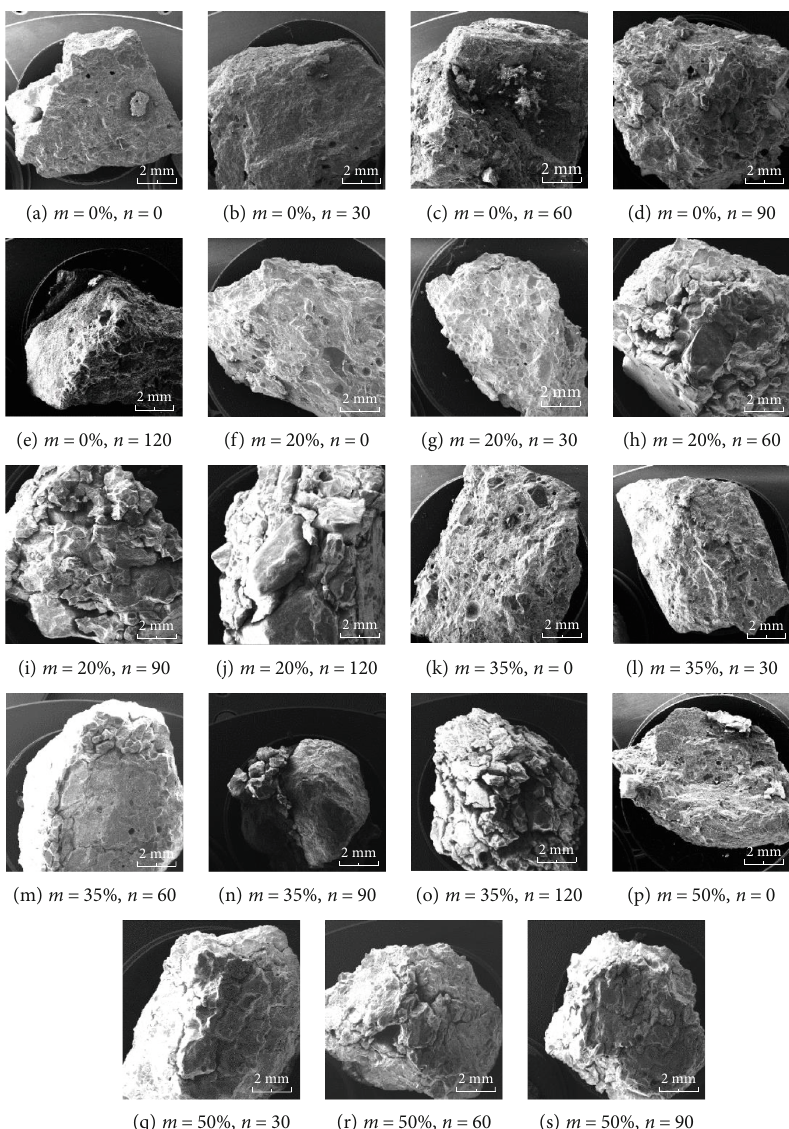
Figure 3: Macroscopic failure characteristics of concrete after freeze-thaw cycling and